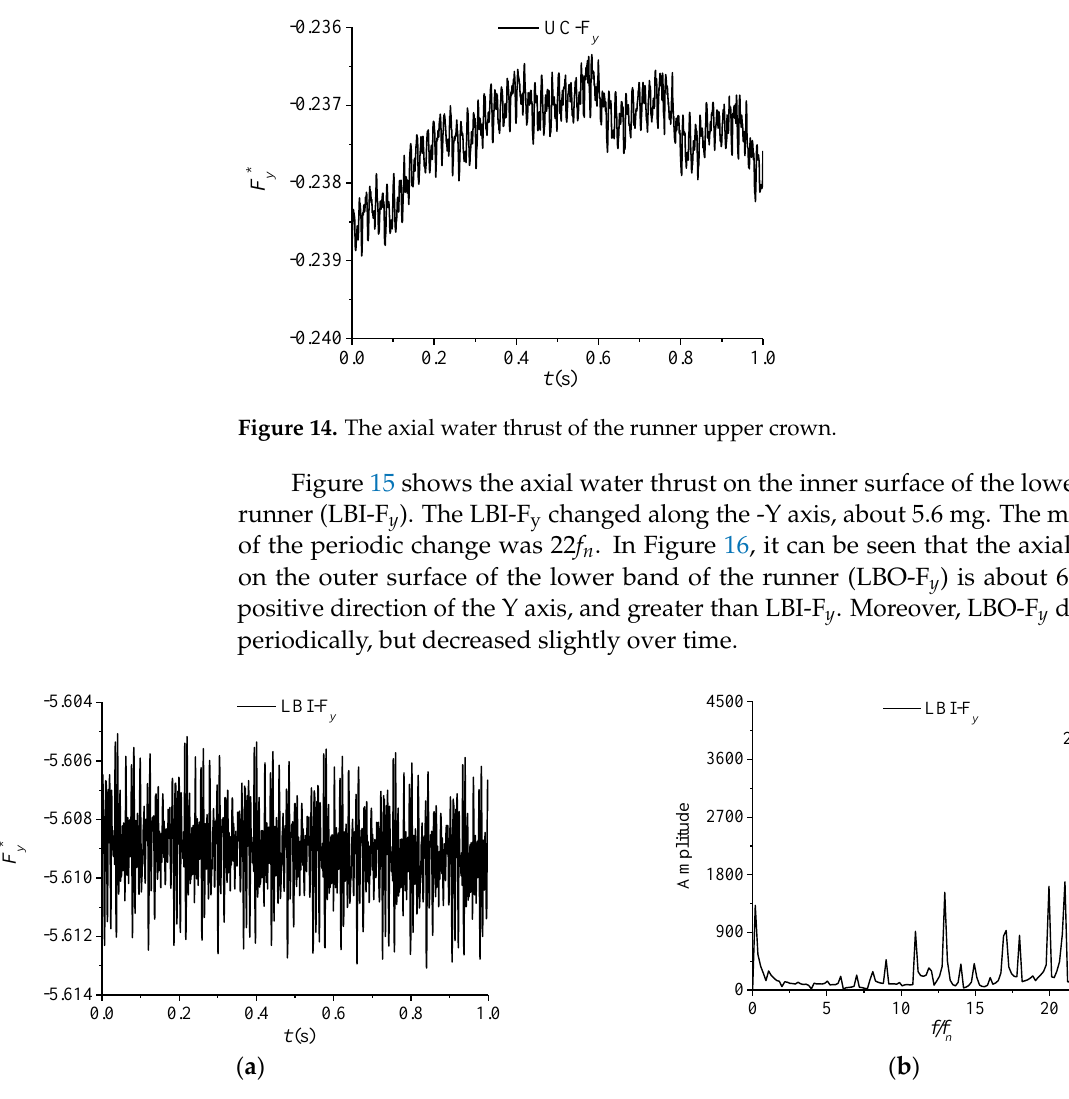
Figure 13. The axial water thrust of the runner upper crown outer surface. ( a ) Time domain diagram of UCO-F y . ( b ) Fre-